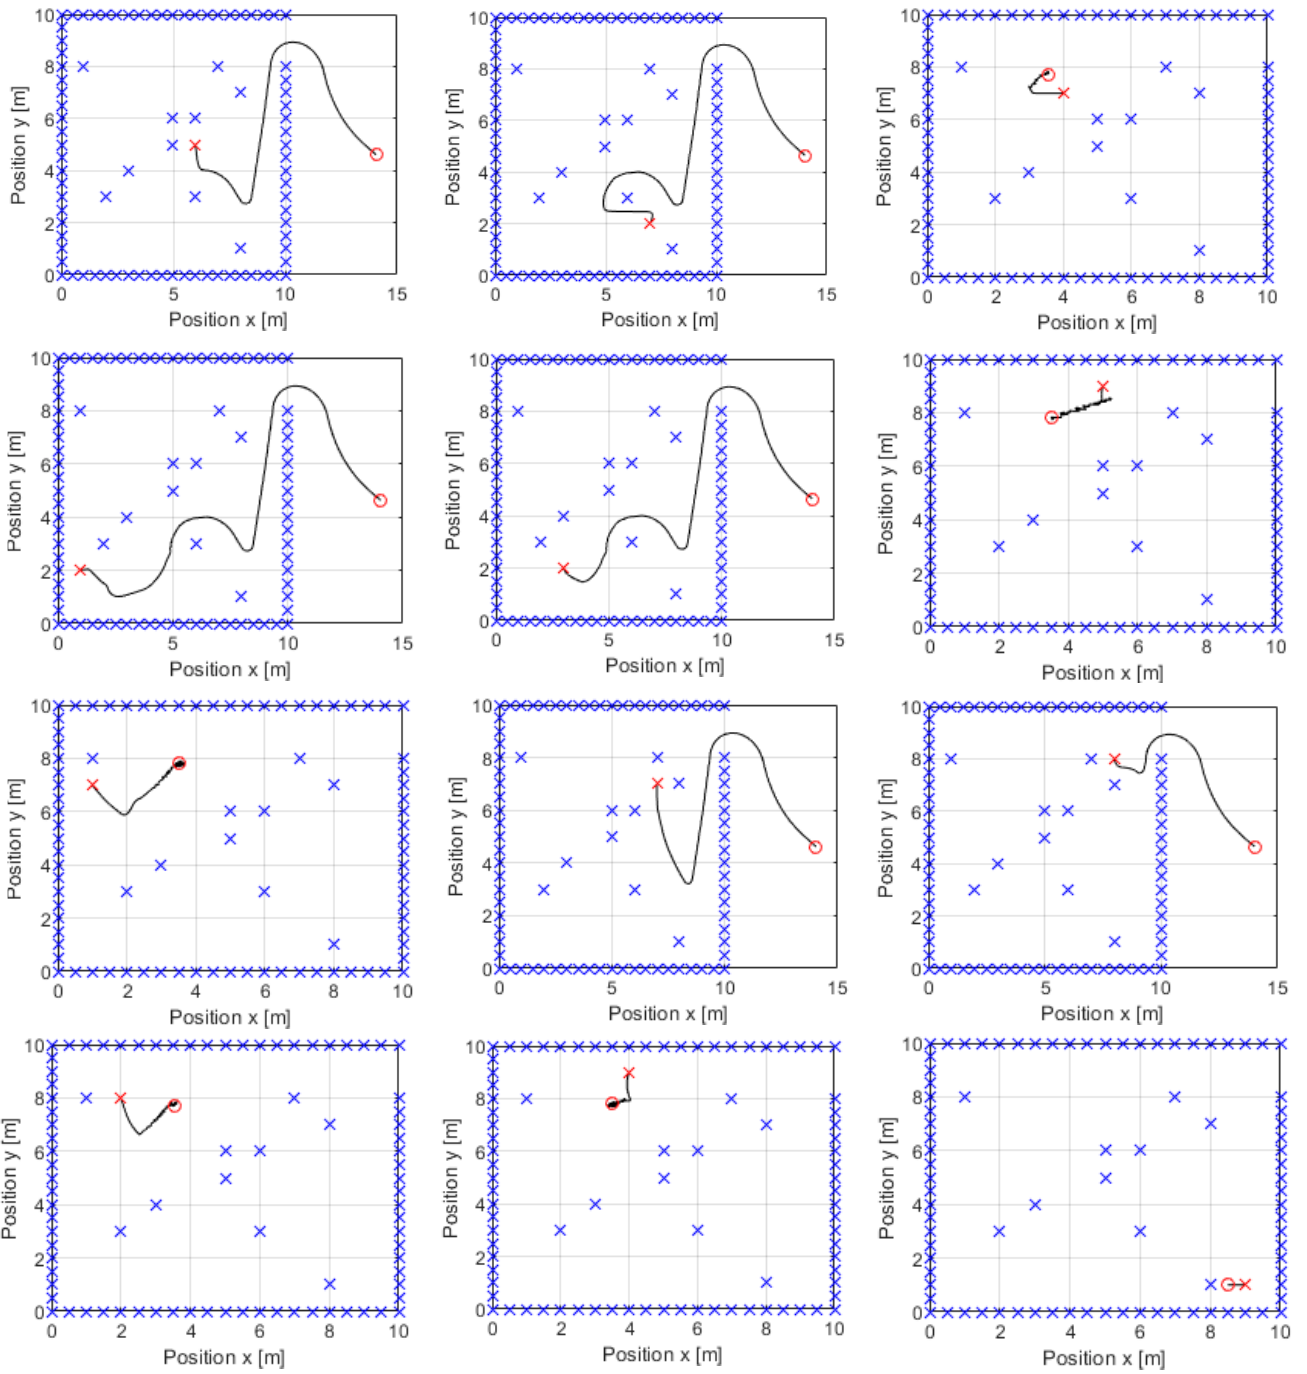
Figure 14. Different trajectories generated by Agent J, starting the navigation from different origins.